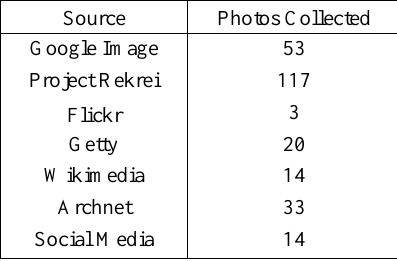
Table 1 . Data according to sources.